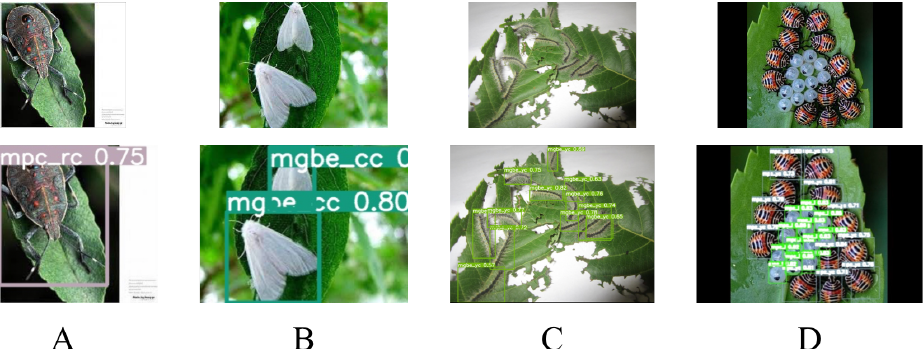
Figure 4. Detection results for different density scenarios on our method. ( A – D ) indicates the objects to be recognized from sparse to